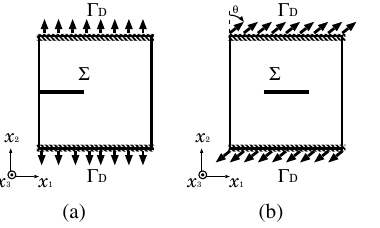
Fig. 3 Domain of the numerical simulation of mode I+II crack growth